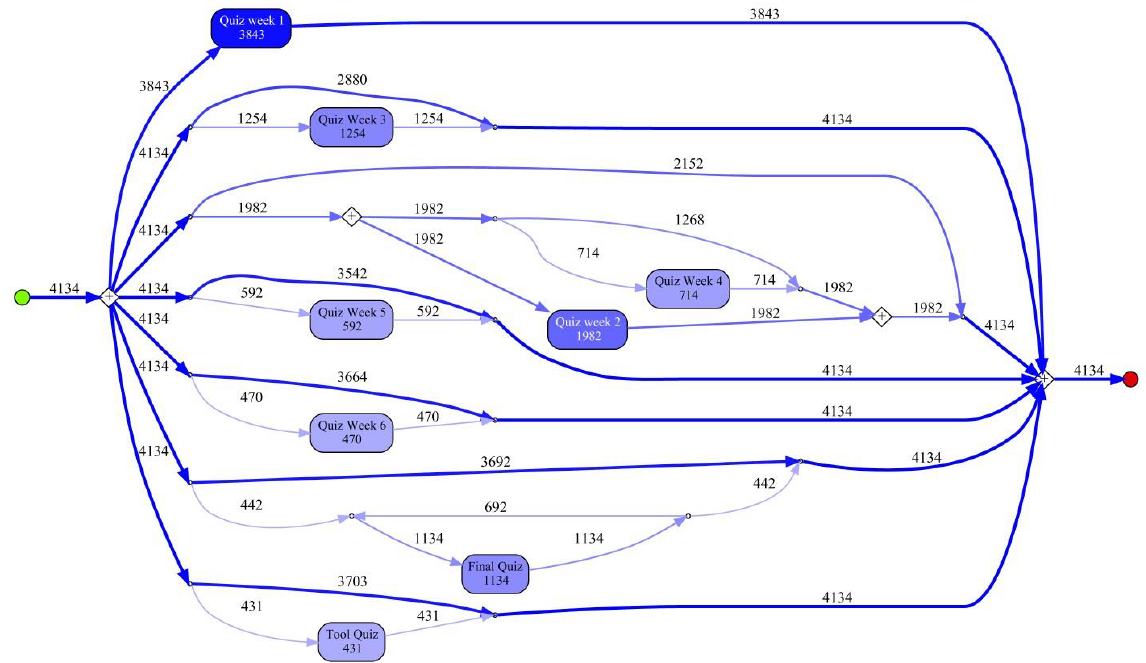
Figure 4 . Quiz submission behaviour of students that did not obtain a certificate.